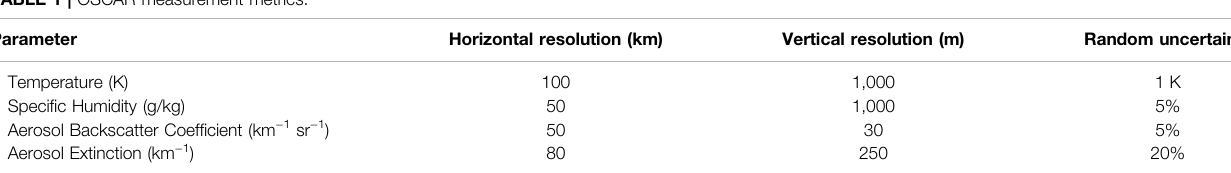
TABLE 1 | OSCAR measurement